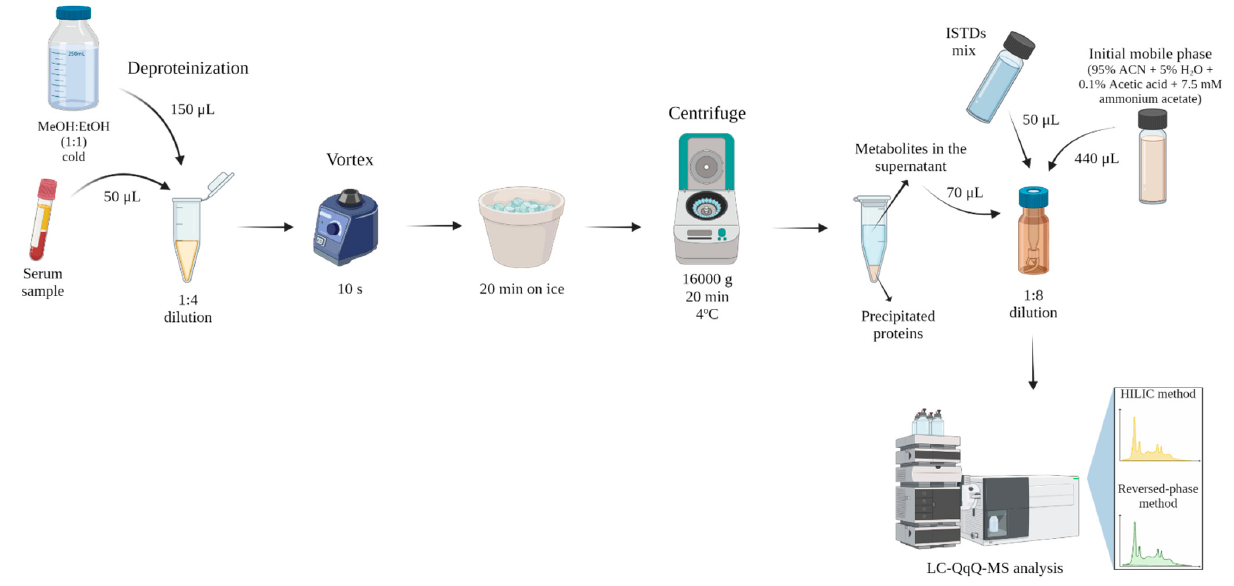
Figure 5. Scheme of serum sample preparation. ACN : acetonitrile; ISTDs : internal standards; MeOH:EtOH : methanol:ethanol.